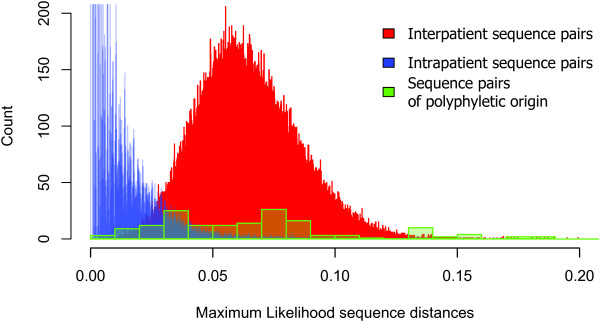
Distributions of pairwise sequence distance for sequence pairs drawn from the same patient (intrapatient) or from different patients (interpatients), and for sequence pairs of polyphyletic origin from putative superinfected patients. The distribution of the distances for 80.000 randomly chosen sequence pairs of different patients is shown in red. Intrapatient sequence distances are shown in blue (truncated above 200 to optimize the scale for comparison). The green overlaid histogram depicts polyphyletic sequence pairs from potentially superinfected patients (identified from the initial phylogenetic analysis). There is no clear cutoff for the distribution of intrapatient distances.